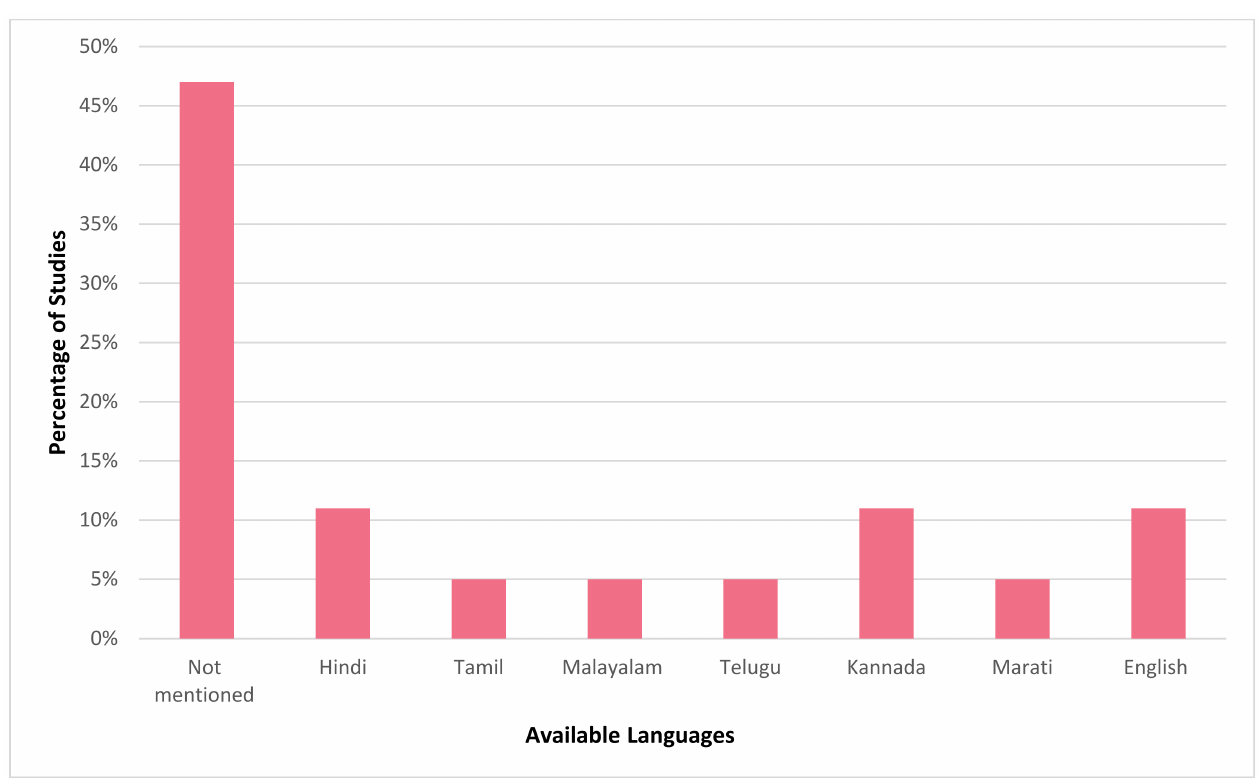
Figure 5. Type of mobile health (mHealth) interventions used in each study that was analysed for this review.